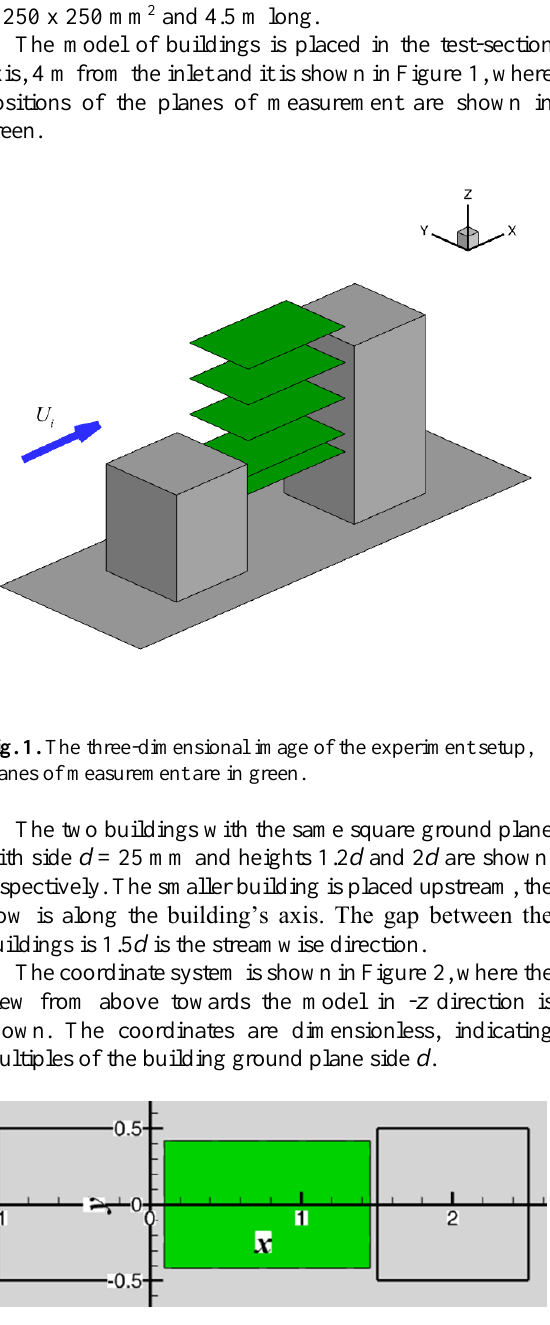
Fig. 2. The Cartesian coordinate system, view from above.